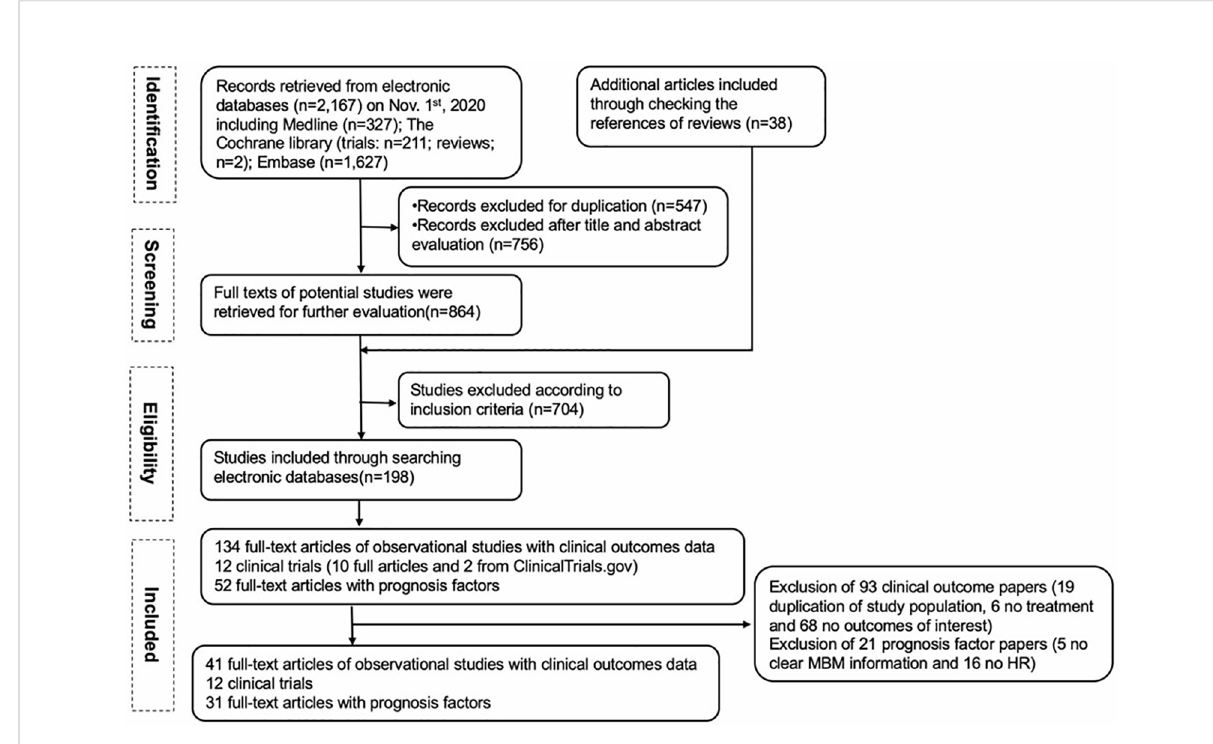
FIGURE 1 The study fl ow